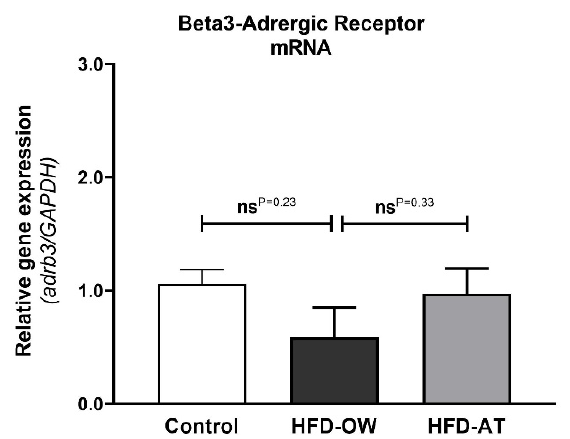
Figure 2. Relative gene expression of Beta3 adrenergic receptor (Adrb3) in the study groups. HFD-OW: High-fat diet-induced overweight; HFD-AT: high-fat diet with aerobic training. Data are presented as mean±SEM. Data were analyzed by one-way ANOVA followed by Tukey's test.